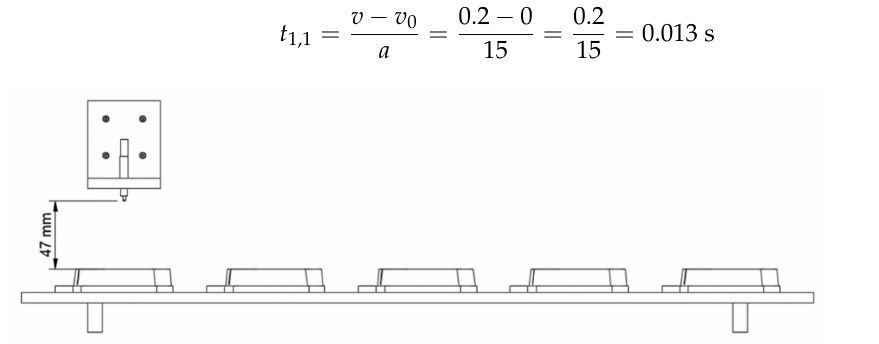
Figure 12. Distance of Indenter and Brake Pad